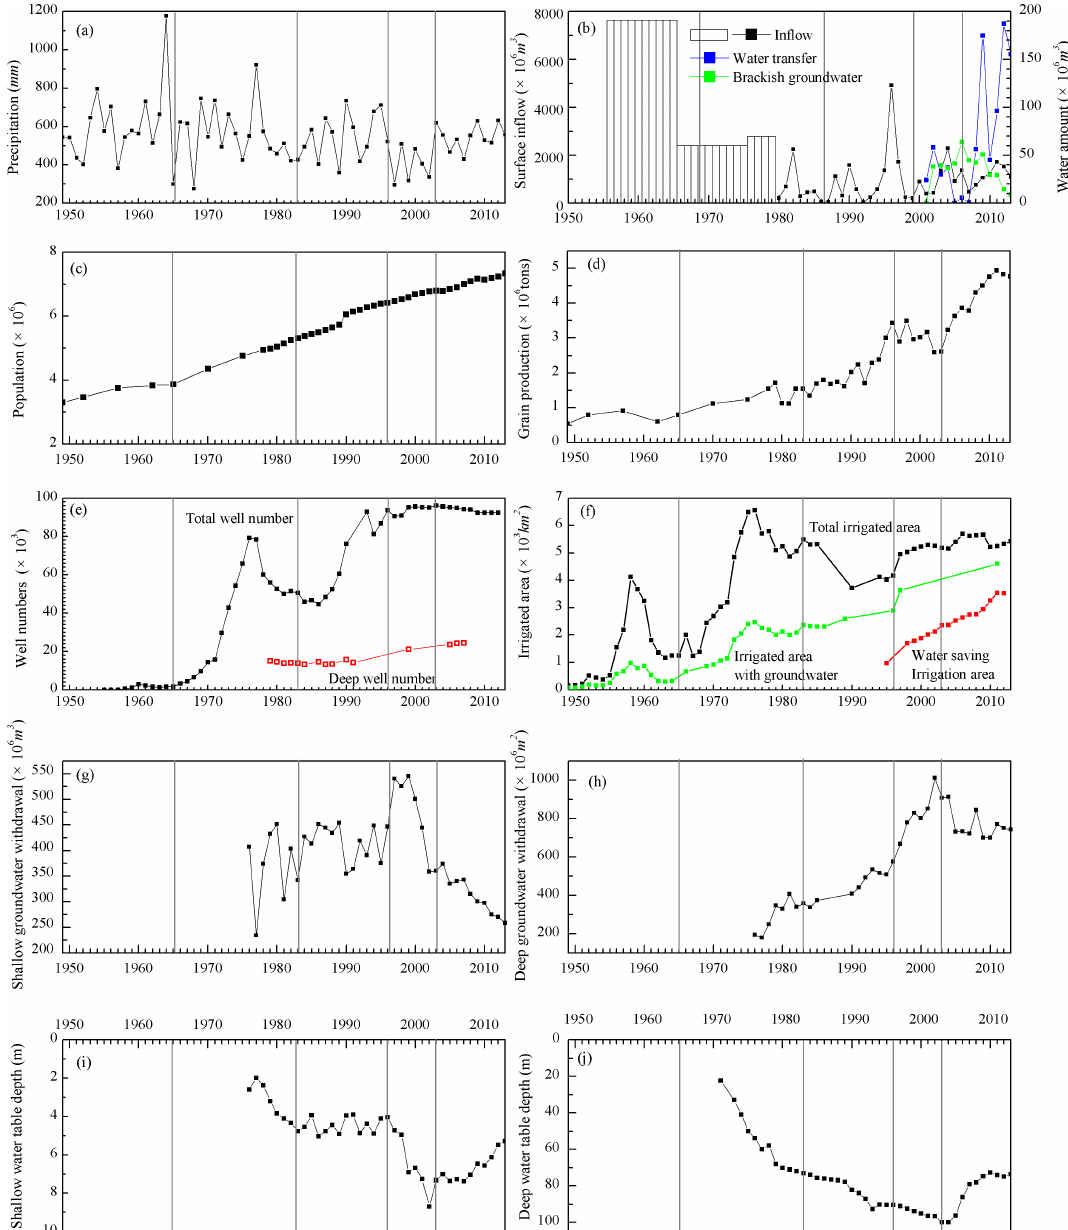
Figure 2. Time series of (a) precipitation, (b) surface inflow (before 1980 the data is the average value), (c) population, (d) grain pro- duction, (e) well numbers (red line is referred the number of deep well), (f) irrigated area, (g) shallow groundwater withdrawal, (h) deep groundwater withdrawal, (i) shallow water table depth, and (j) water table depth of the depletion cone in Cangzhou during the study period